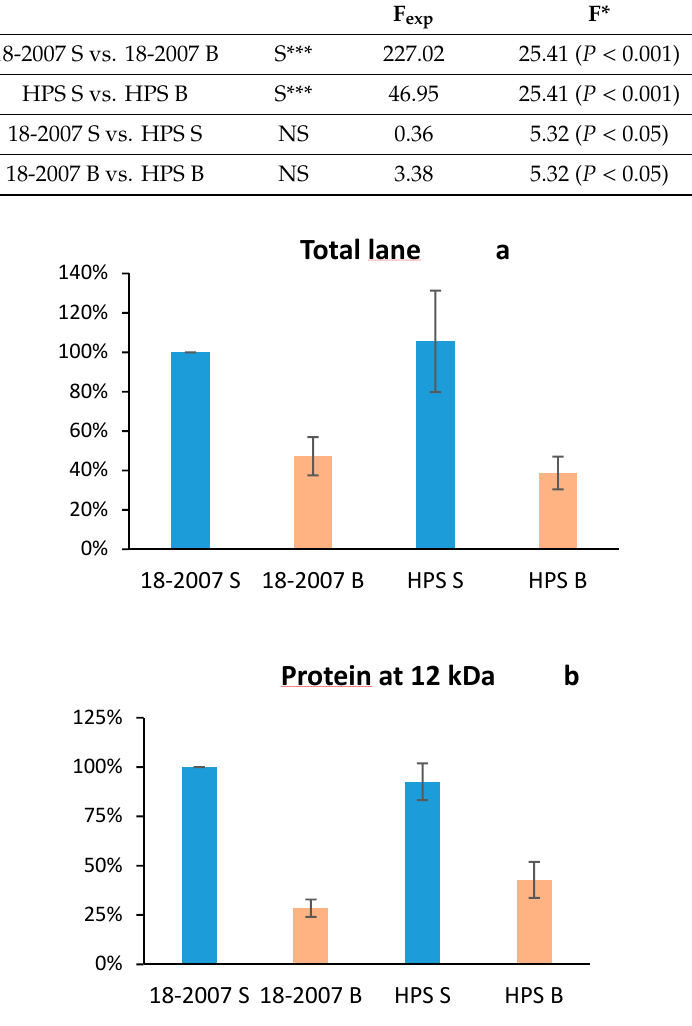
Figure4. ProteincontentsinthewinesafterSDS-PAGE + AgNO 3 staininganddensitometricintegration.; Figure 4. Protein contents in the wines after SDS-PAGE + AgNO 3 staining and densitometric ( a ) total proteins; ( b ) protein at 12 integration.; ( a ) total proteins; ( b ) protein at 12 kDa.